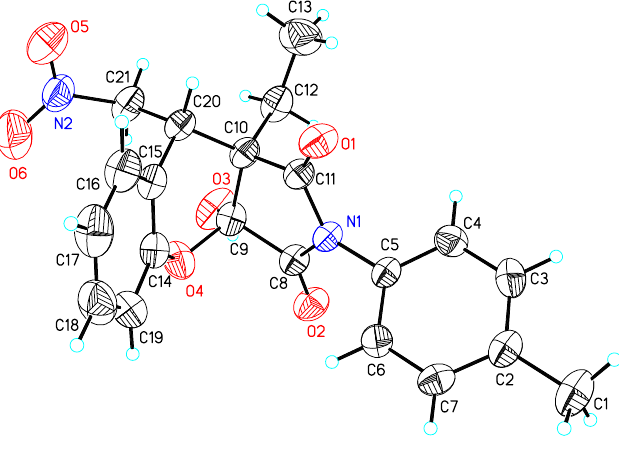
Figure 3. X-ray crystal structure of 3ca .